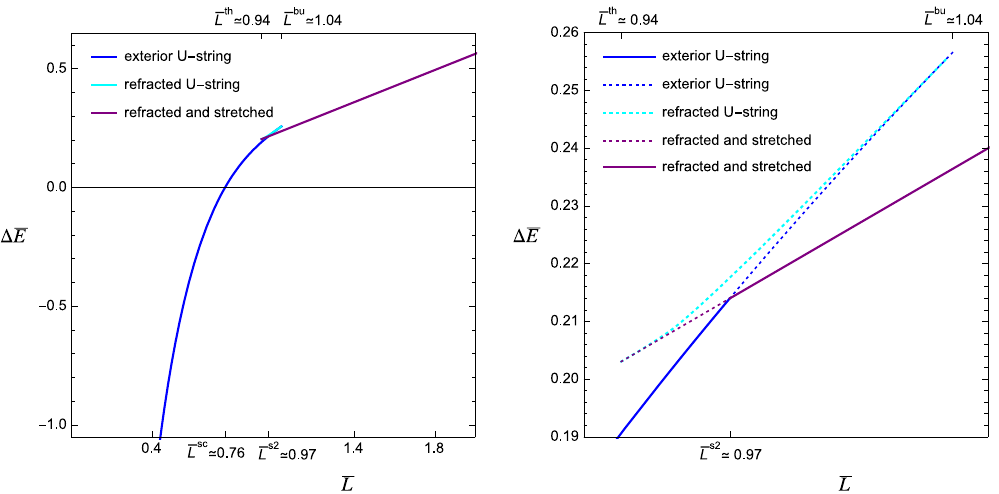
Figure 3 . The energy (cid:1) (cid:22) E of a quark-antiquark pair as a function of its separation (cid:22) L . The dual portrayal corresponds to a U-shaped string with both of its endpoints on the same boundary in the wormhole